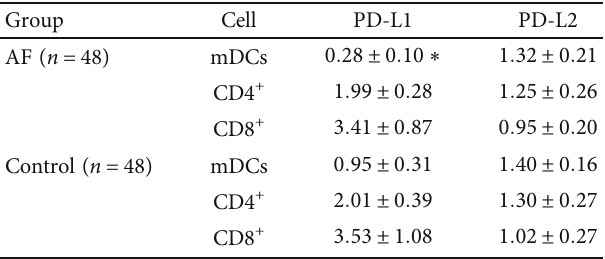
Table 4: Changes of PD-L1 and PD-L2 expression on external blood mDC cells in two groups ð x ± s Þ